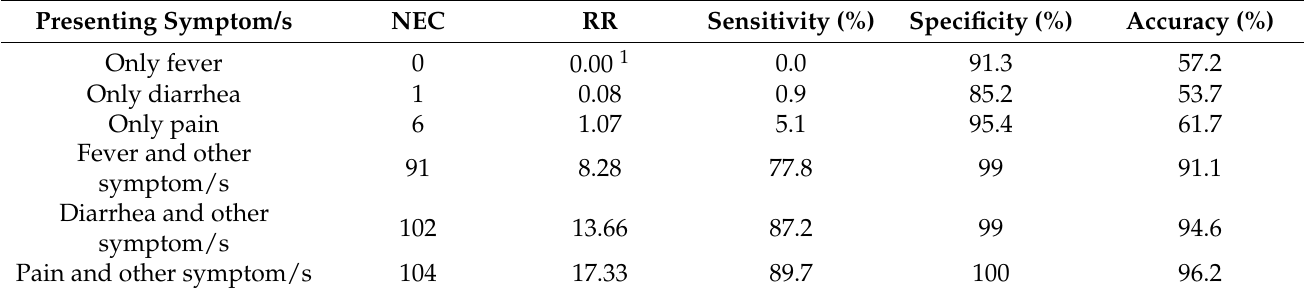
Table 3. Sensitivity, specificity, and accuracy of symptom combinations for the diagnosis of